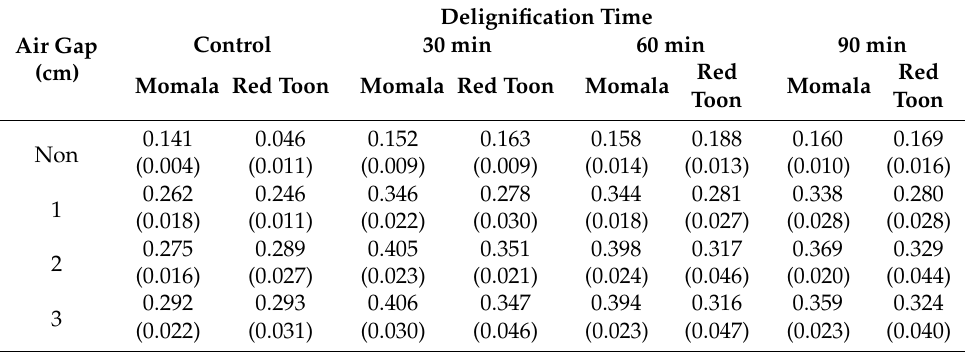
Table 1. NRC values of momala and red toon before and after delignification treatment and addition of an air gap.